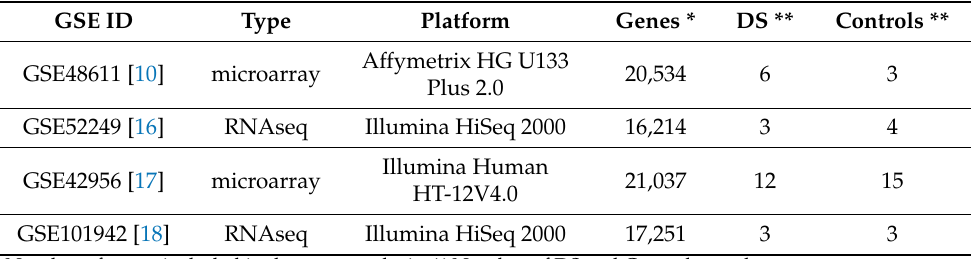
Table 1. Datasets included in the gene expression meta-analysis of trisomic (DS) and euploid (Controls)